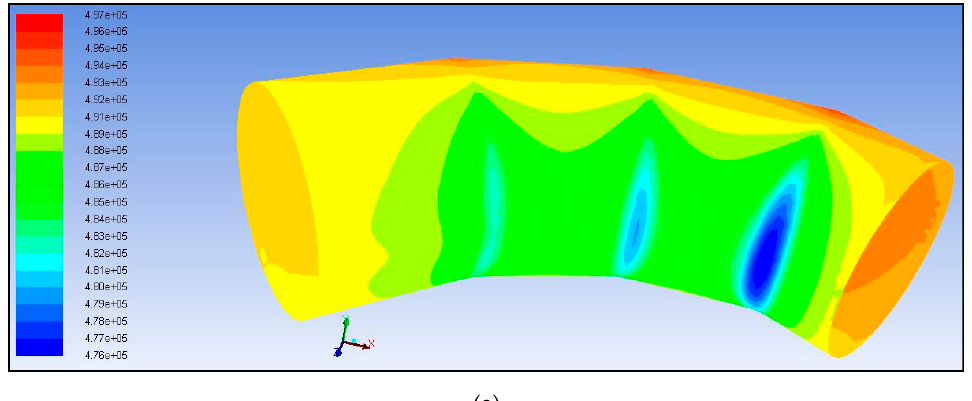
Figure 17. Mesh of fluid zone. Notice the refined mesh near the boundary.